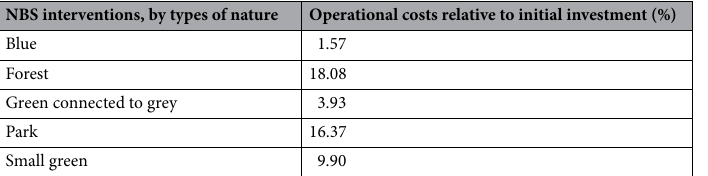
Table 2. Estimated operational costs relative to initial investment, by type of NBS intervention. Source: own computations based on UNA